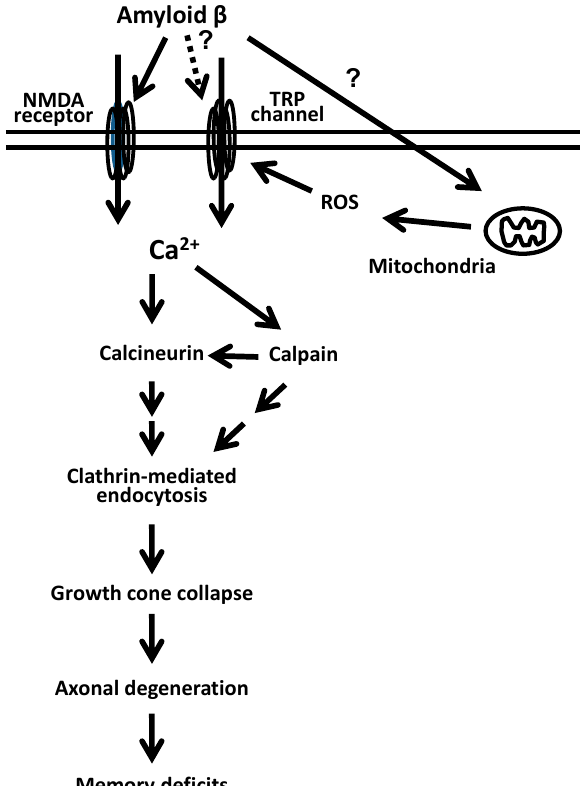
Figure 1. A β -induced growth cone collapse via clathrin-mediated endocytosis [31].